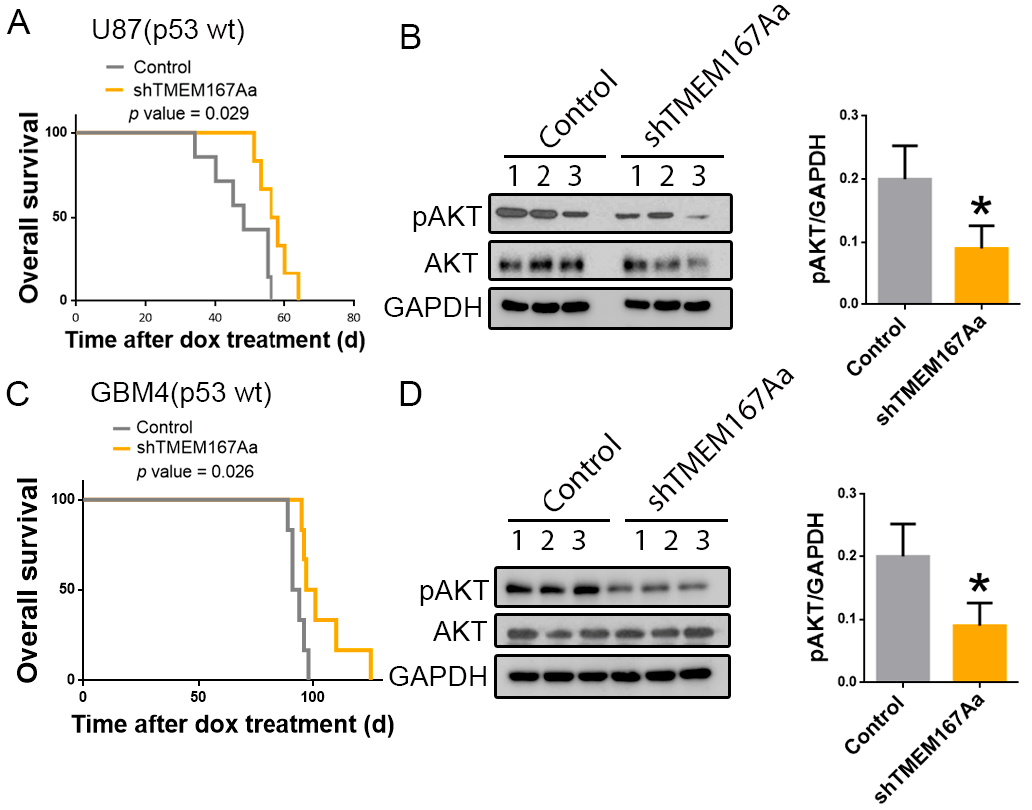
Figure 5. Downregulation of TMEM167A in EGFRwt and EGFRamp/mut cells impairs orthotopic glioma growth and receptor signaling. ( A – D ) U87 (A,B) and GBM4 (C,D) cells